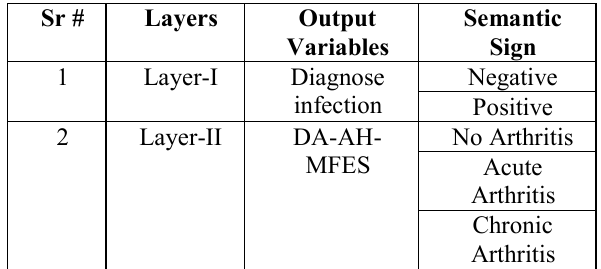
Table 3. Layer-I & Layer-II output variables